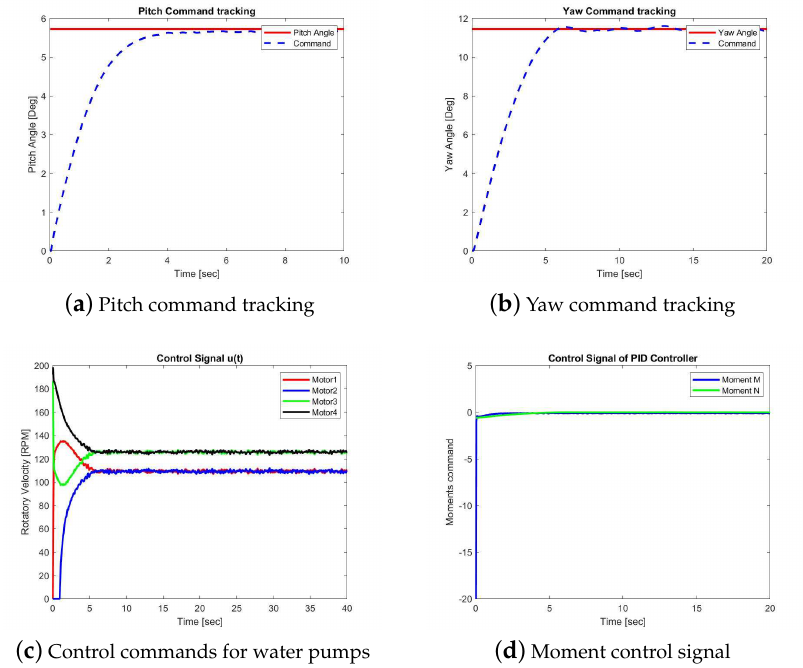
Figure 7. Case 2B: Simulation results of the PID